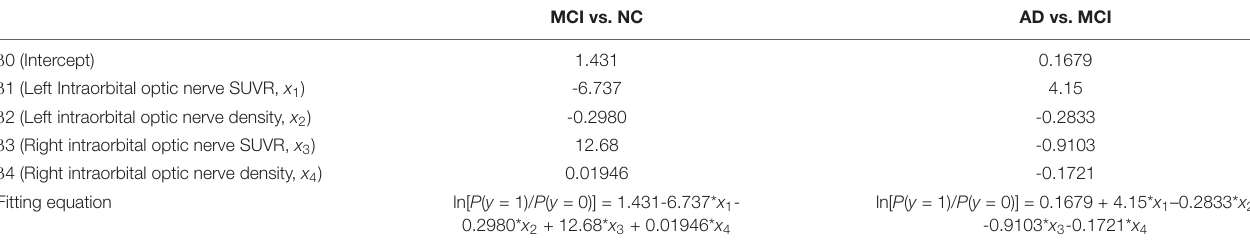
TABLE 5 | Results of multiple logistic regression.